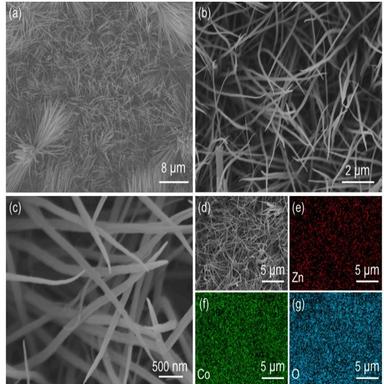
(a–d) SEM images of ZnCo2O4 NWs, and the corresponding elemental mappings of (e) Zn, (f) Co, and (g) O.